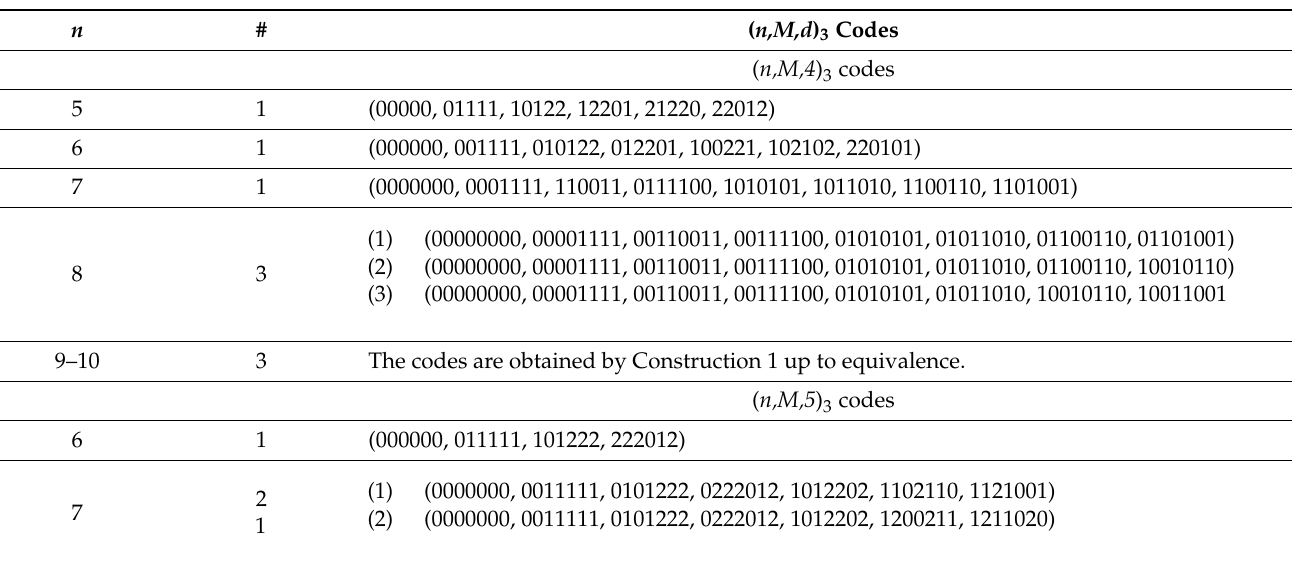
Table 3. ( n,M,d ) 3 inequivalent equidistant